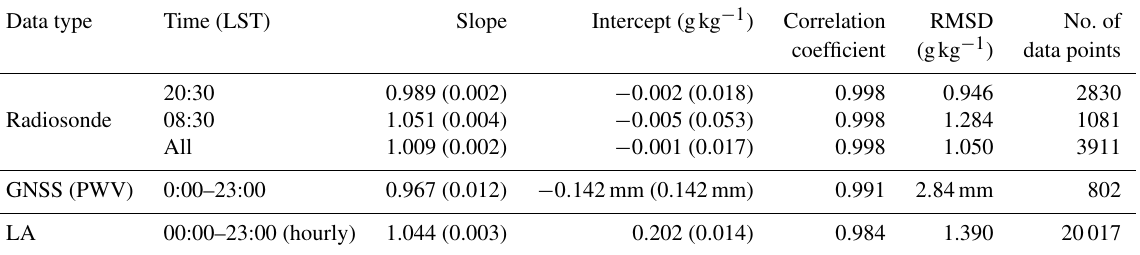
Figure 13. Scatter plots (a) of PWV obtained with the MRL system against PWV obtained from GNSS data from 2 August to 6 Decem- ber 2016 and (b) their difference (PWV Lidar − PWV GNSS ) versus PWV GNSS . In (b) , the open squares and vertical lines show the means and standard deviations of the difference at intervals of 10mm. Table 2. Results of water vapor measurements by the MRL compared with data obtained by other instruments or from local analyses. Values in the parentheses of slope and intercept are the statistical